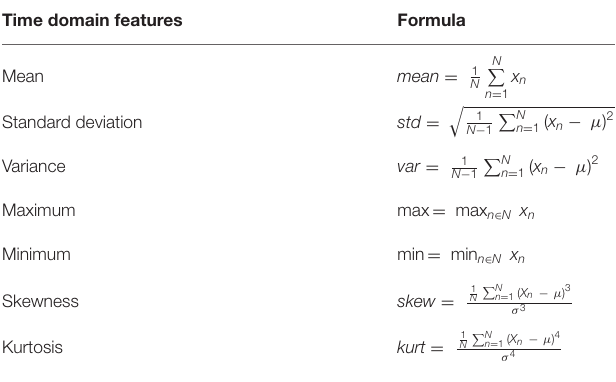
TABLE 1 | Formulas of the time-domain